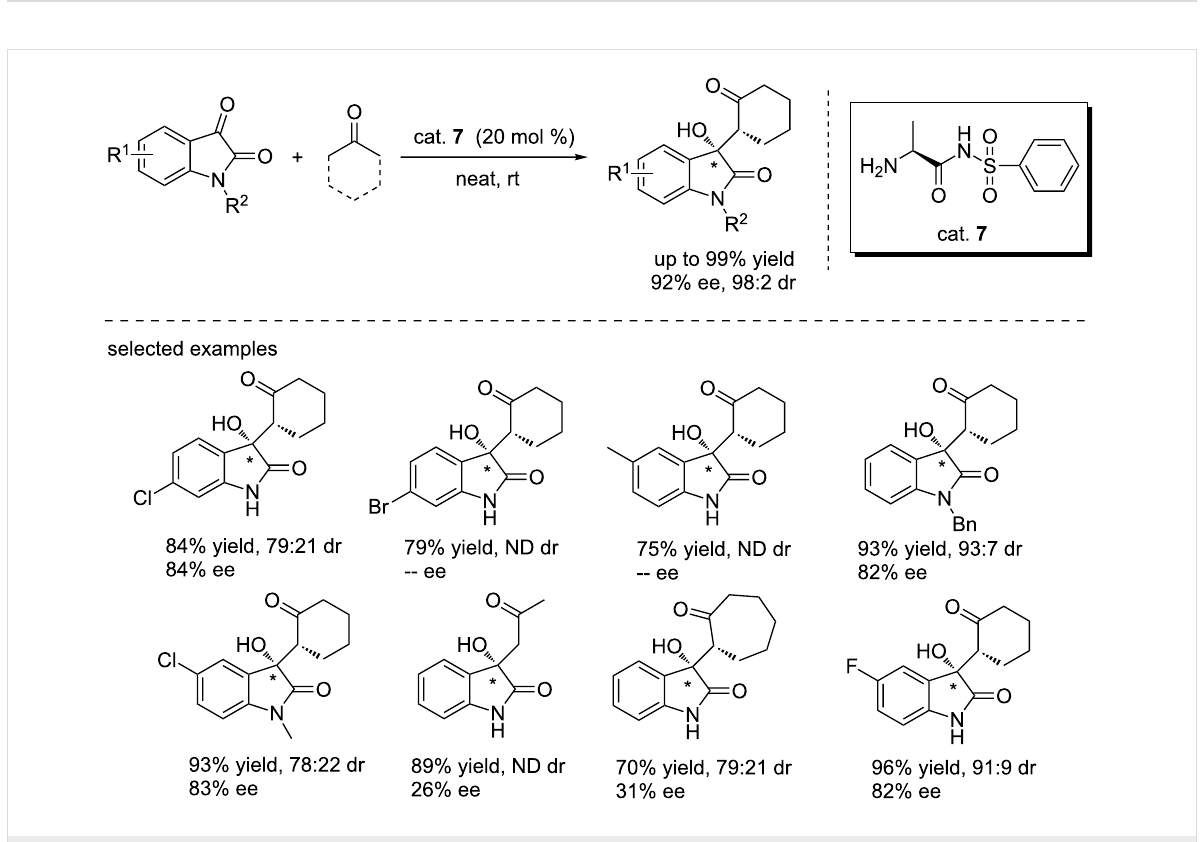
Scheme 20: Asymmetric aldol reactions between ketones and